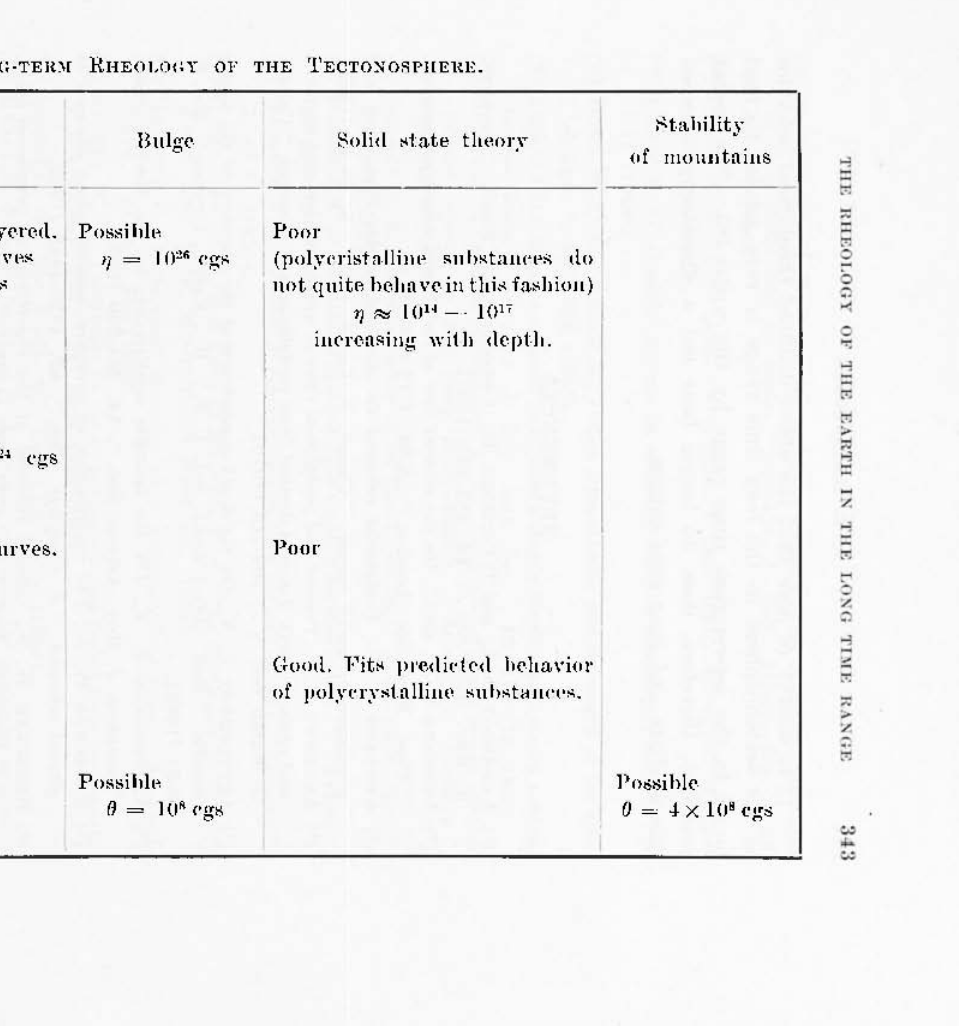
Table r - LO:>;(;·TEIOr RHEOL01;Y 01' THE